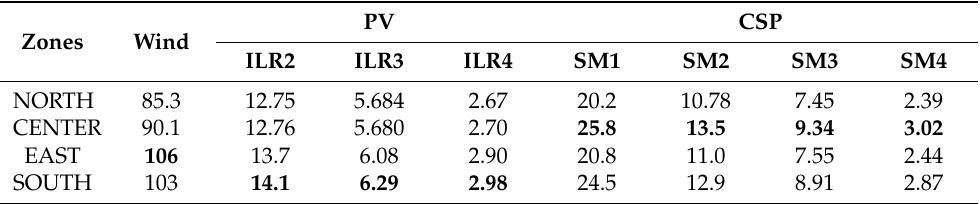
Table 6. Maximum-penetration ratios (yr/T e ),